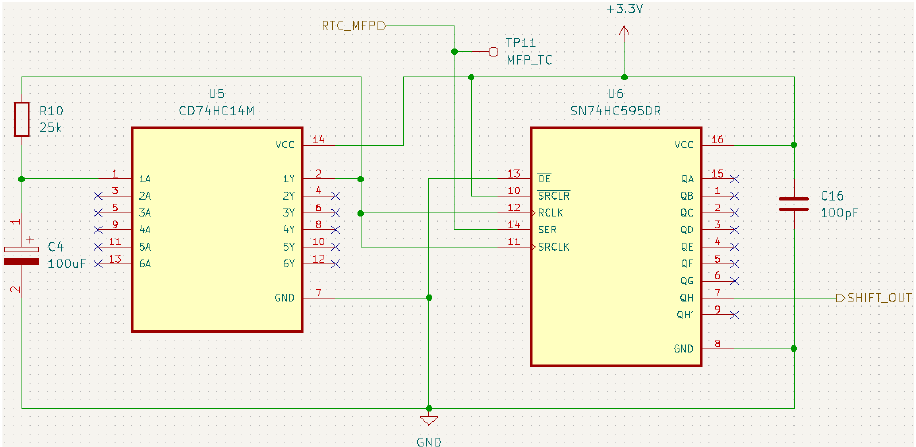
Figure 7. Schematic of the signal delay circuit.